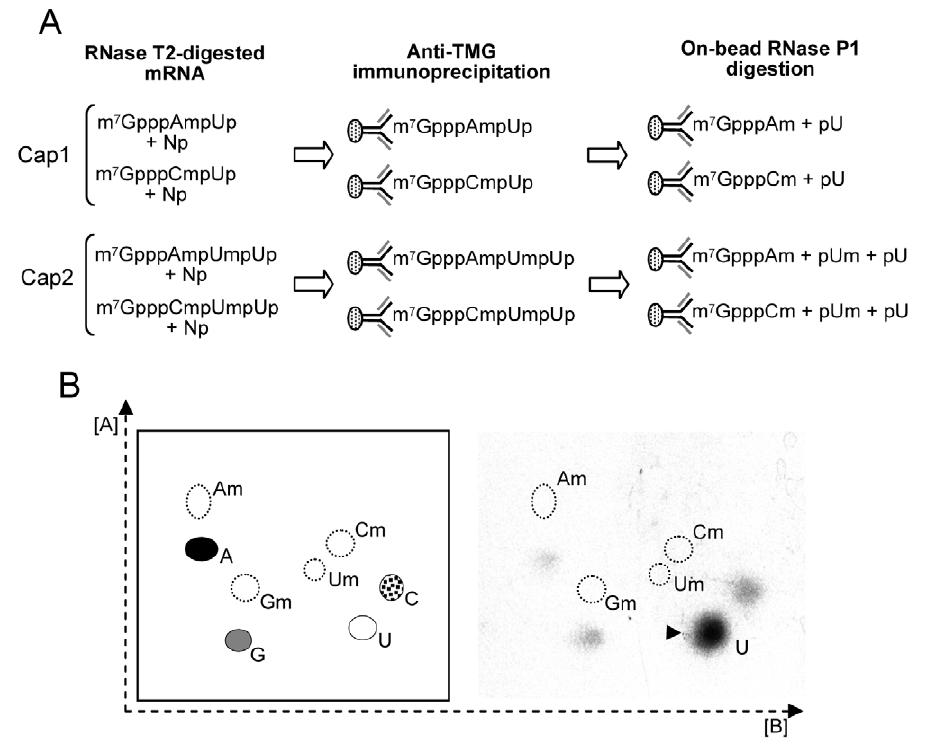
Figure 7. Evaluation of a cap 2 modified nucleotide in T.vaginalis mRNA by 2D-TLC analysis. A. Scheme of experimental approach. For simplicity, uridine is shown at position + 2 and + 3 as this is the most common nucleotide at these positions [28,29]. The presence of cap 1 modified nucleotides Am or Cm (Figure 4B) predict the release of 3 9 -phosphate mononucleotides (Np), and 2 of 4 possible cap structures depending on the absence or presence of a cap 2 modified uridine upon RNase T2 digestion. The presence of only a cap 1 structure (top) predicts release of m 7 GpppAmpUp or m 7 GpppCmpUp; if a cap 2 is present (bottom) m 7 GpppAmpUmpUp or m 7 GpppCmpUmpUp is predicted. Subsequent anti-TMG immunoprecipitation and elution by RNase P1 digestion predicts release of only unmodified ribonucleotides or both unmodified and 2- O -ribose modified ribonucleotides in the absence or presence of a cap 2 ribonucleotide, respectively. B. Detection of unmodified ribonucleotides at + 2 of T. vaginalis mRNAs using the scheme shown in A. and 2D-TLC (right). Migration standards are shown in left